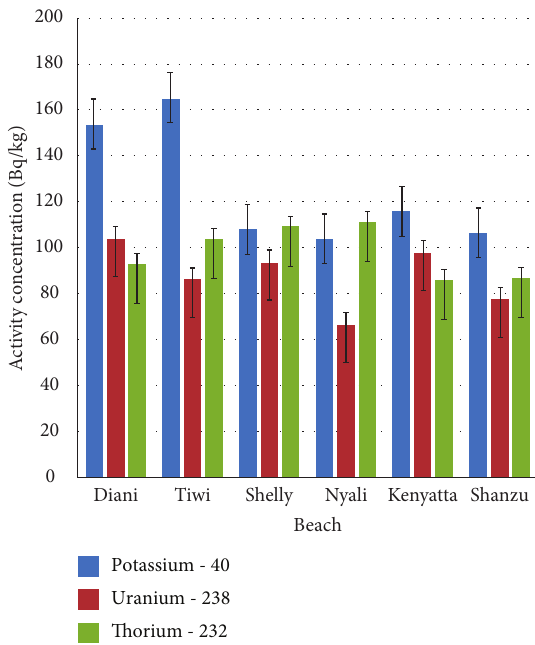
Figure 2: Average activity concentration of 232 Th, 238 U, and 40 K values measured in the sand samples from the six beaches (activity concentration of 40 K has been reduced by a power of ten for